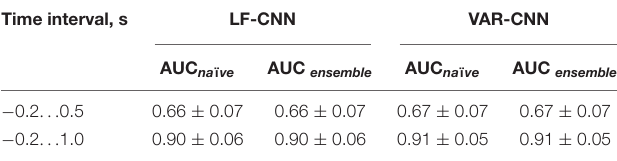
TABLE 2 | Group mean ROC AUC values ( M ± SD).